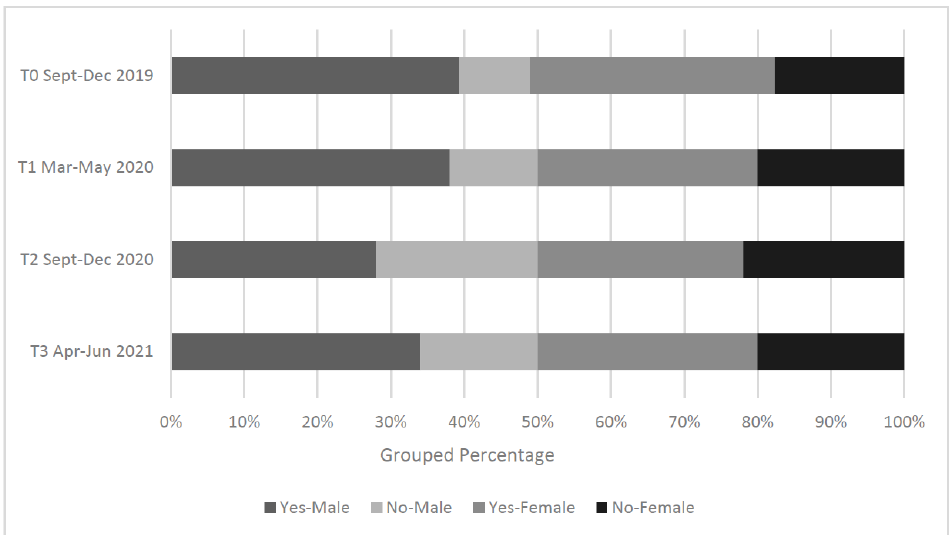
Figure 1. Percentage of male (n = 75) vs. female (n = 183) participants who reported meeting the government suggested guidelines for PA levels during the four COVID-19 related timepoints as outlined in this study.